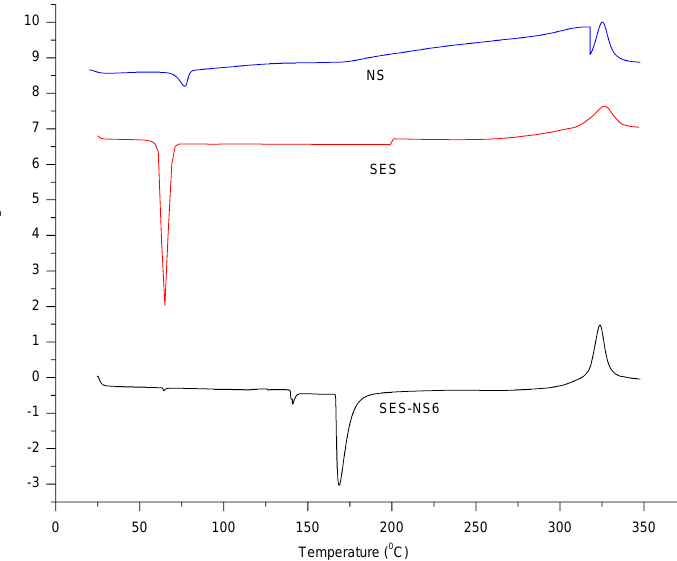
Figure 5. Differential scanning calorimetry thermograms of blank nanosponges (NS), sesamol (SES), and bioactive-loaded selected batch (SES-NS6).